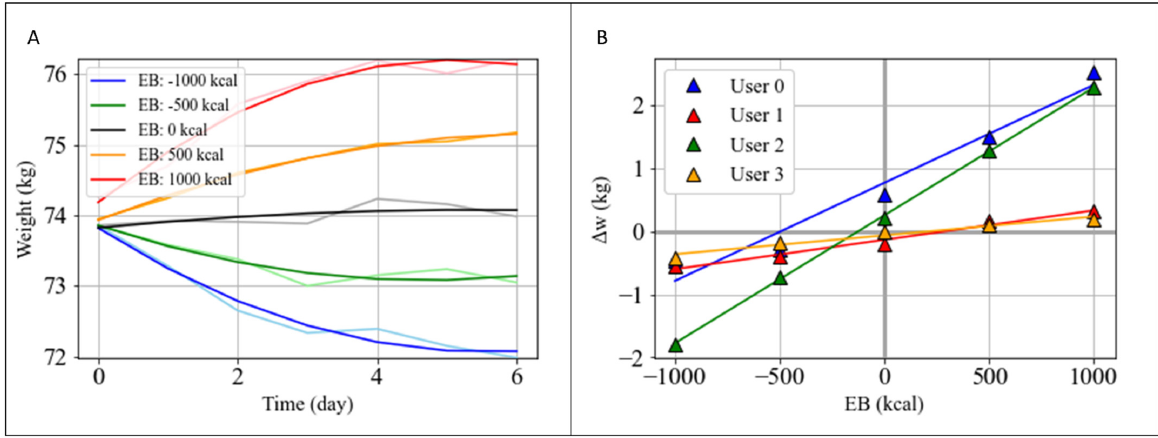
Figure 5. Effects of diet plans on user metabolism. ( A ) WFS performed at different EB values on the data of User 2, keeping constant the percentage of macronutrient intake (50%, 20%, 30%, respectively). Weight data were fitted with a second order polynomial. ( B ) Weight variation ∆ w calculated from the first and last values of the fit of the second grade versus the EB value and for each user. Table 3. Metabolic plasticity m and quality factor q for each user.